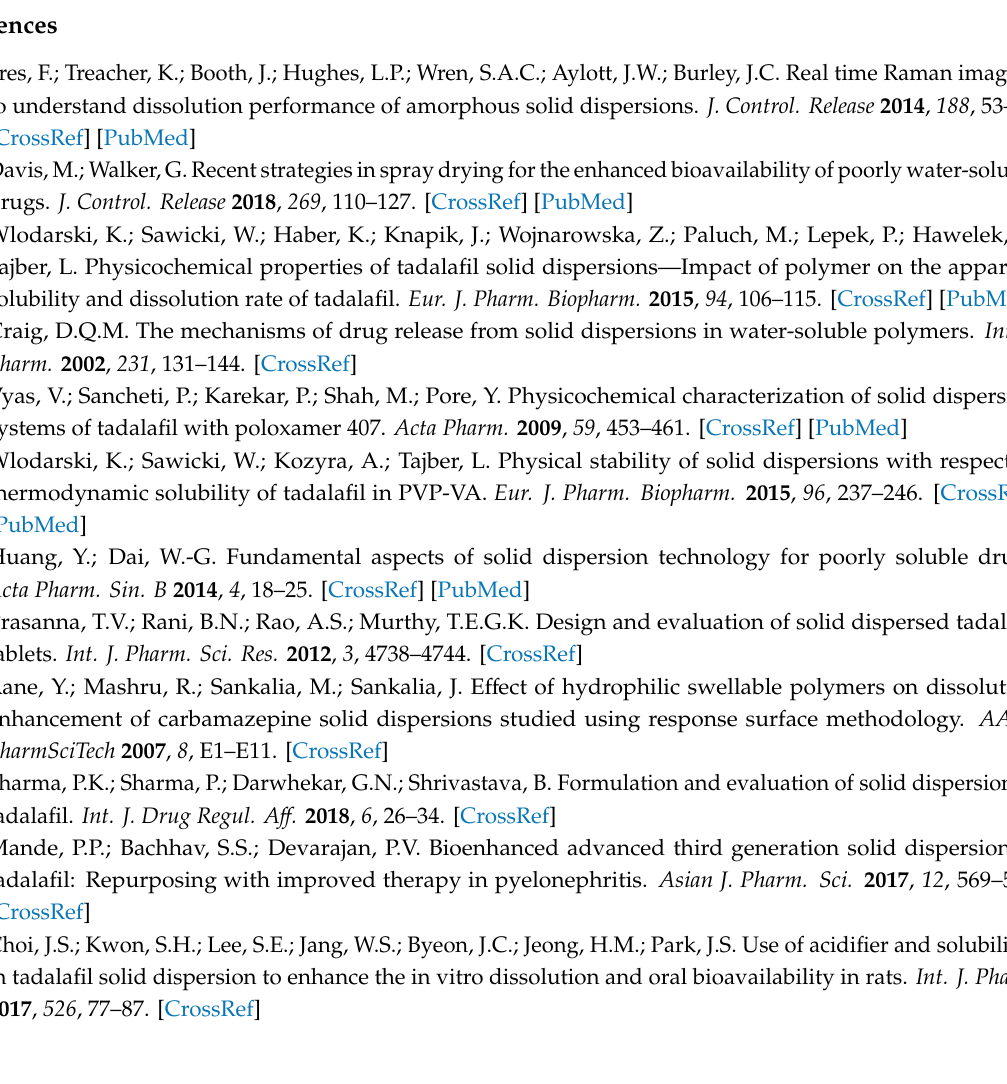
Figure A3. X-ray diffraction patterns of extruded SDs after 9 months: ( a ) TAD-K12 and ( b ) TAD- Figure A3. X-ray di ff raction patterns of extruded SDs after 9 months: ( a ) TAD-K12 and ( b ) K64.